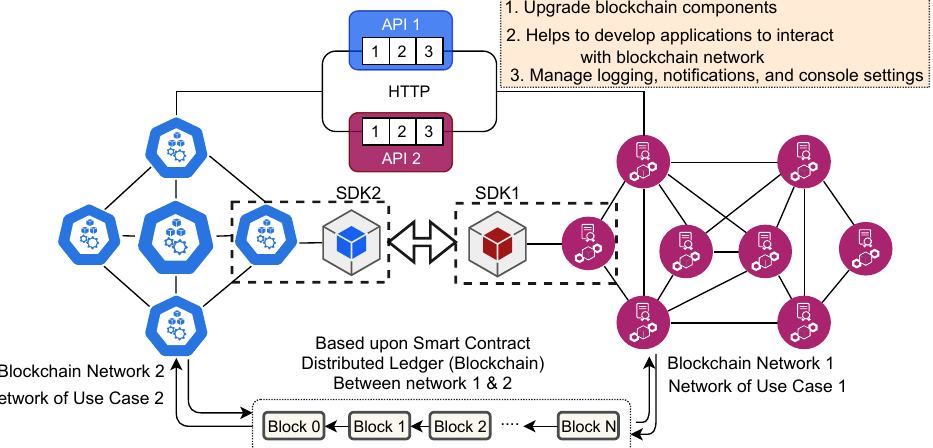
Figure 3. Blockchain-based interoperable